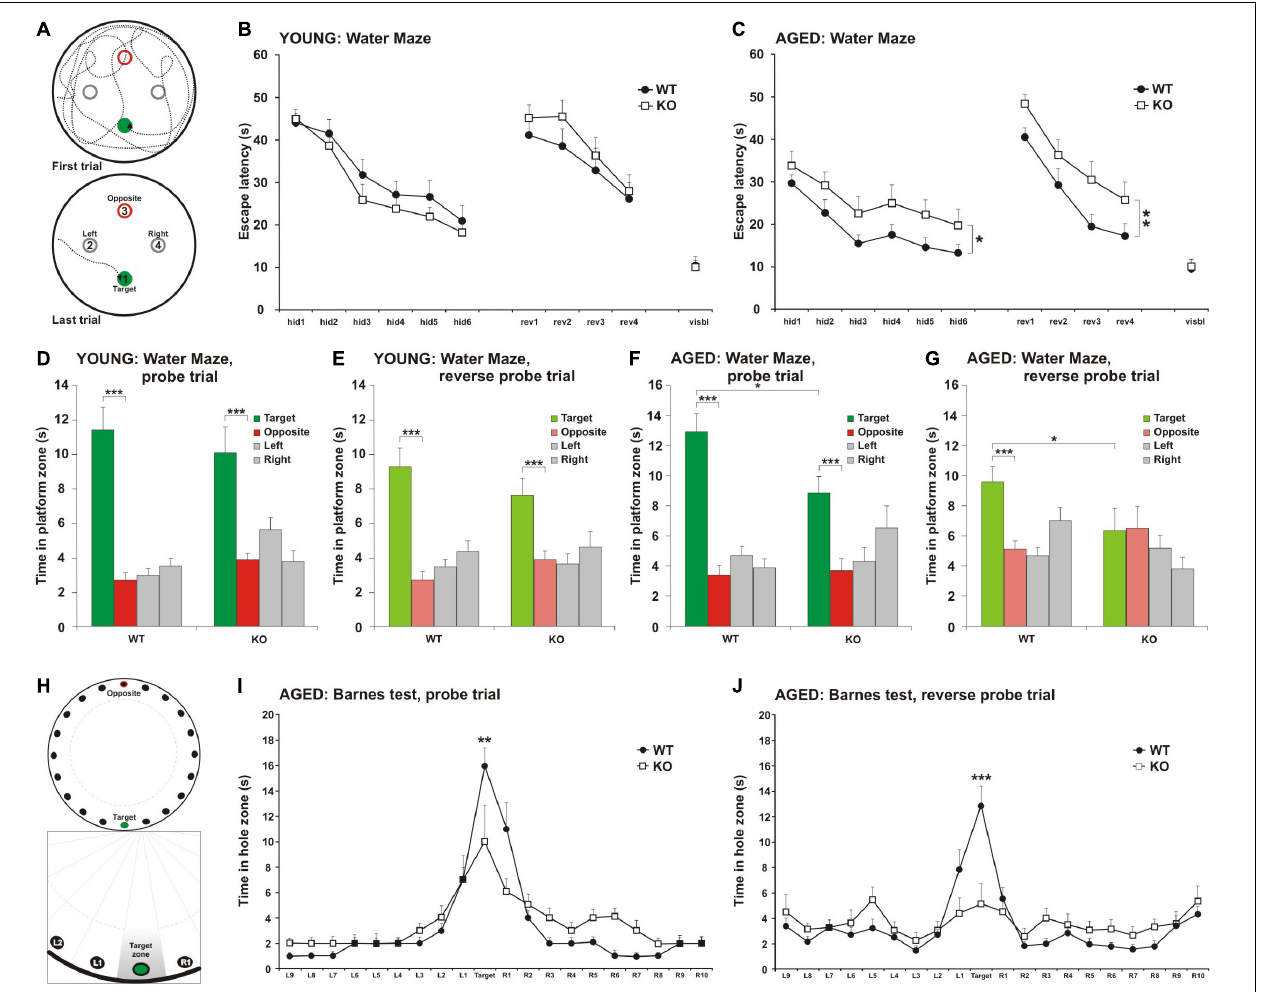
FIGURE 1 | Impairment in spatial learning and memory in MIM KO mice. (A) Illustrative images of mouse trajectories in the water maze during the first and last learning trials. (B,C) Learning curves of the water maze task during six trials over three days (hid1–hid6). Reverse-learning curves during four trials over 2 days (rev1–rev4). Group means ± SEM are shown for the escape latency to the hidden platform. (D,F) A 60 s probe trial for search bias was conducted on Day 4. (E,G) A 60 s reverse probe trial for search bias was conducted on Day 6. Time spent in near vicinity of the platform location (target), opposite poolside platform location (opposite) or two other corresponding locations symmetrically right and left of the platform. The last trial of the water maze was with a visible platform (visbl). (H) Illustrative images of Barnes maze with 20 holes. An escape box was placed under one box (target). The remaining holes were numbered according to their distance from the target and the letters R (right from target) or L (left from the target). (I) A 90 s probe trial performed on Day 4. (J) A 90 s reverse probe trial performed on Day 6. Time spent in target zone or other corresponding zones around the maze is presented as group mean ± SEM. ∗ denotes statistical significance: ∗ p < 0.05, ∗∗ p < 0.01, ∗∗∗ p <